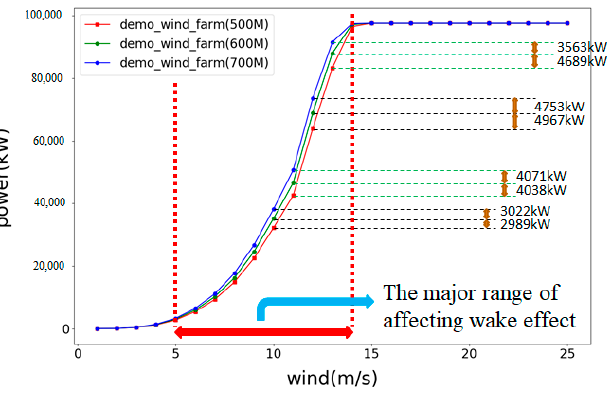
Figure 6. Variation curve of the wake effect caused by different wind velocities and turbines dis- tance.